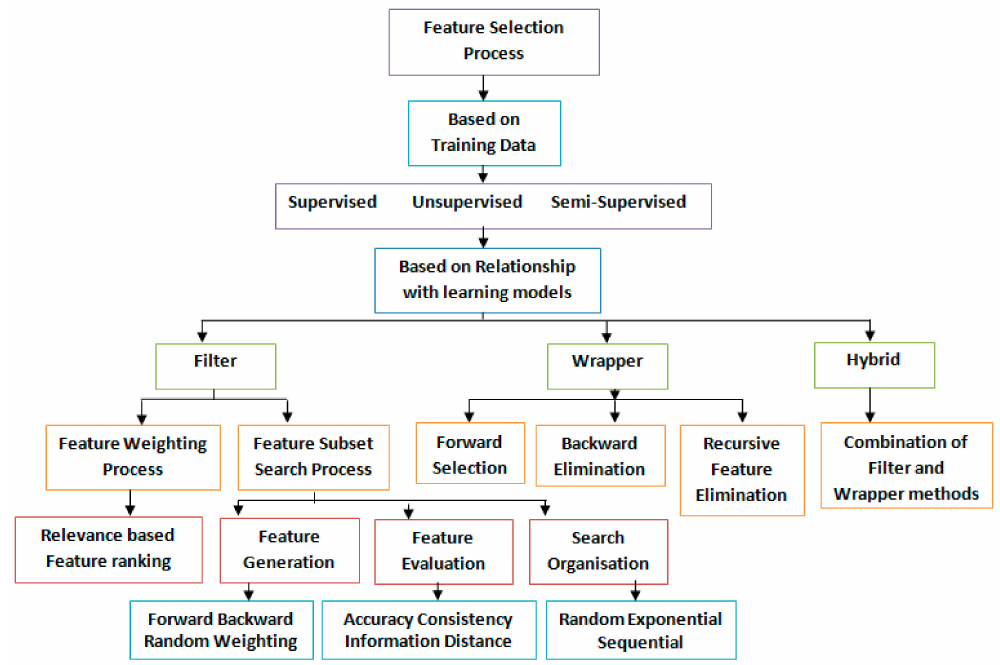
Figure 1. Overview of feature selection methods for machine learning